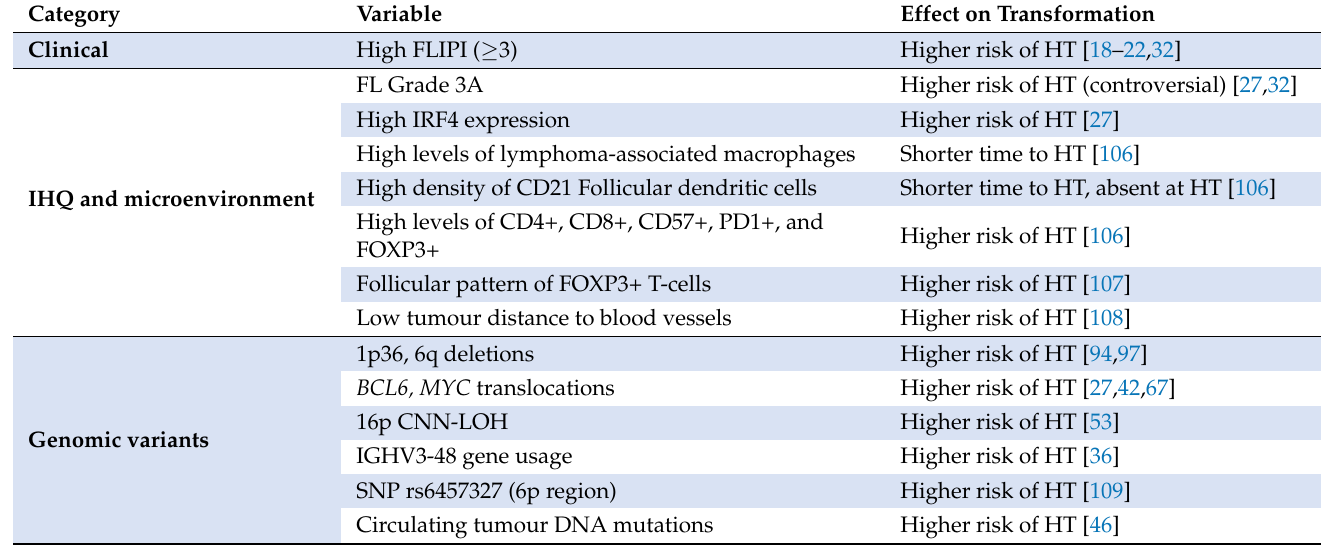
Table 2. Biological, genetic and clinical risk factors at follicular lymphoma diagnosis associated with histological transformation in the